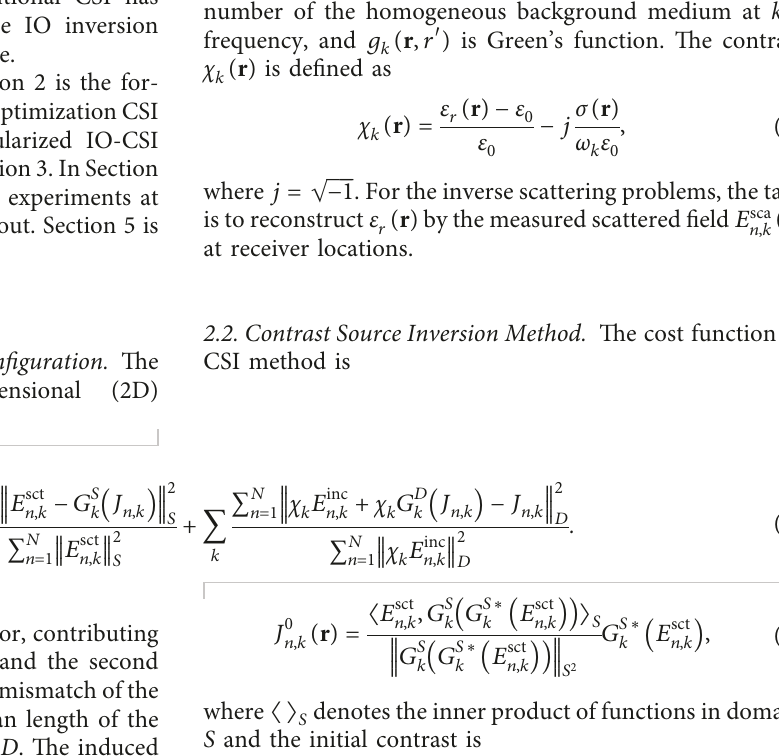
electromagnetic scattering inverse problem is shown in Figure 1. The domain of interest (DOI) D containing un- known scatterers, characterized by ε r ( r ) , is illuminated by incoming waves E inc generated by n th ( n � 1 . . . N) trans- n,k mitter at k th ( k � 1 . . . K) measurement frequency, while the scattered field is measured by M receivers located in the measurement domain S around the domain D